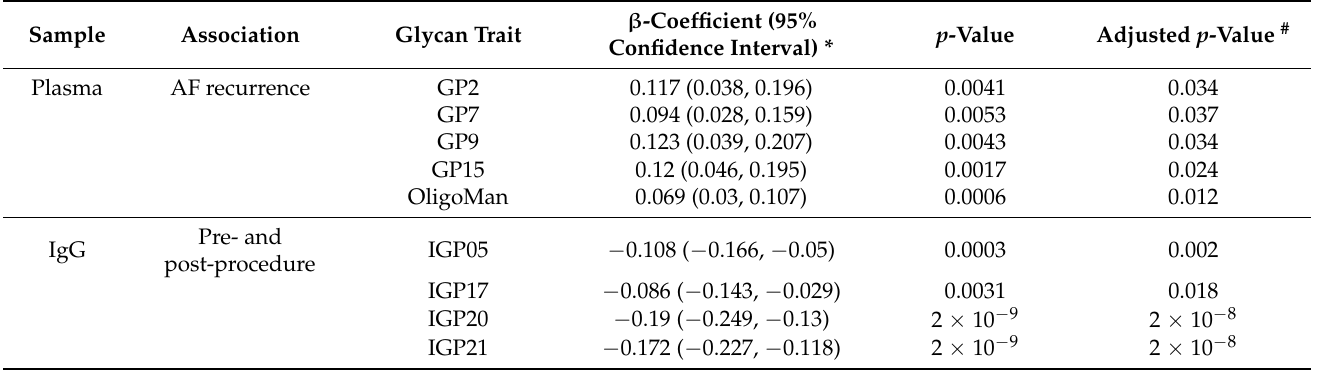
Table 3. Differences of total plasma proteins N -glycosylation between patients with recurrent AF and those without recurrence, and IgG N -glycosylation differences before and 6 months after catheter ablation. Only statistically significant traits and N -glycan structures are shown in the table.